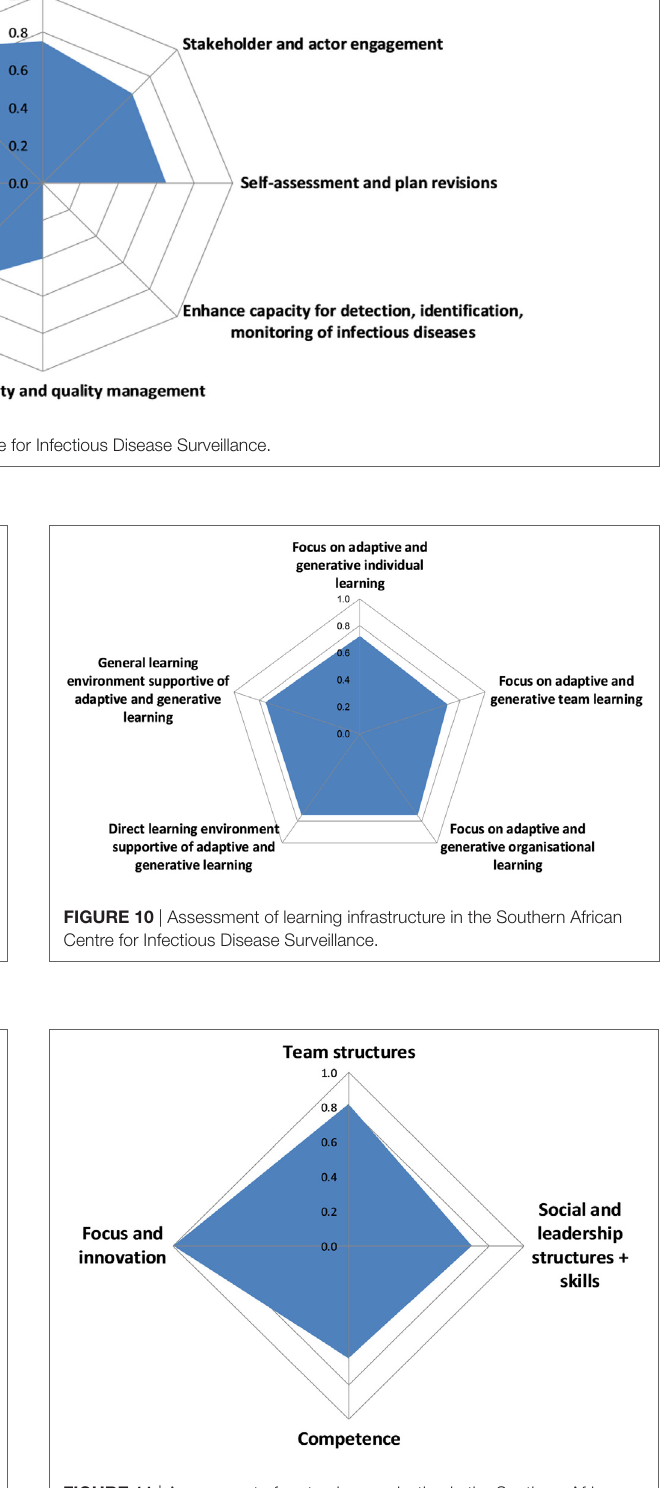
FigUre 11 | Assessment of systemic organization in the Southern African Centre for Infectious Disease